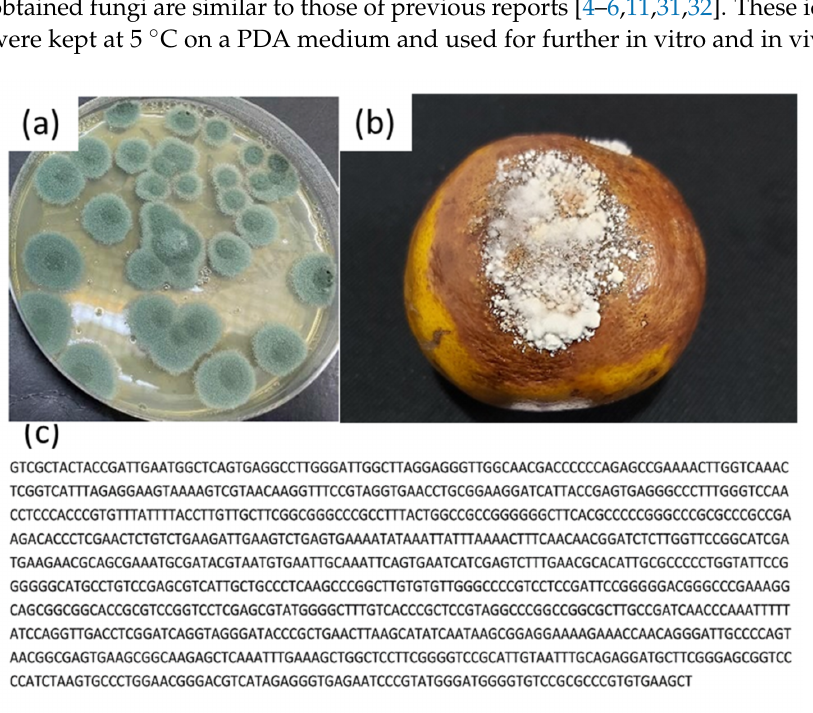
Figure 2. ( a ) Plate and ( b ) fruit were injected with a spore fungal suspension and incubated at 30 ◦ C for 12 days; ( c ) 16s rRNA gene sequences of the Penicillium digitatum.